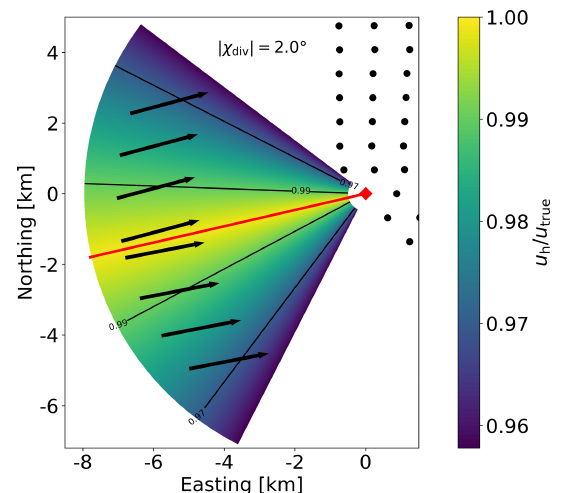
Figure 3. Local deviation in the assessment of the horizontal wind speed u h due to a wind direction deviation | χ div | , here exemplarily set to 2.0 ◦ (cf. Eq. 16). The lidar (red (cid:5) ) directs its beam (red) in the mean wind direction χ ; arrows denote the local deviation of the wind direction χ div